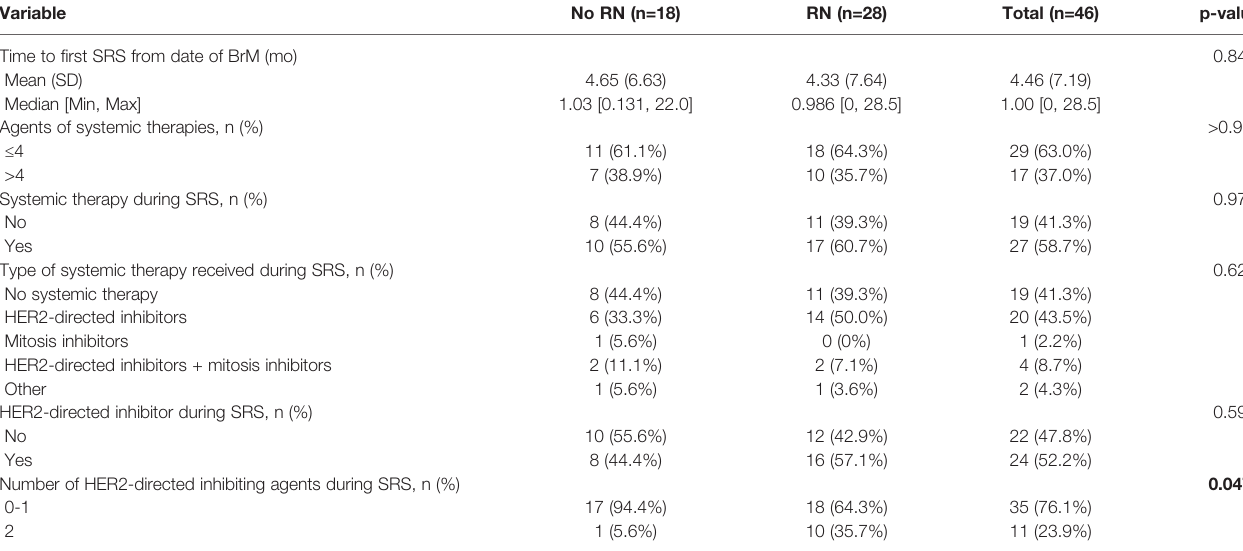
TABLE 3 | Systemic therapy and